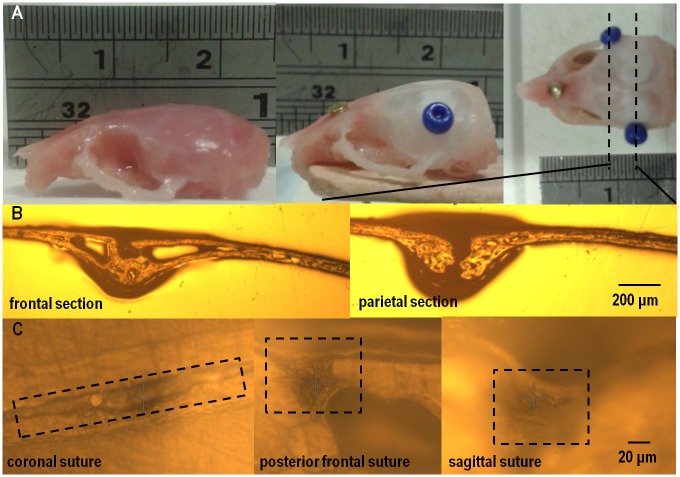
(A) sample preparation, (B) coronal sections through frontal and parietal bones of and (C) coronal, posterior frontal and sagittal suture from left to right in three different WT P20 mice.